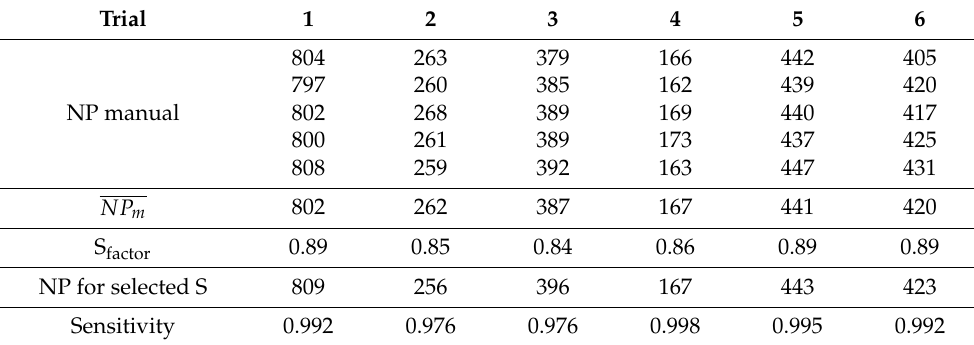
Table 4. Results for Sensitivity.